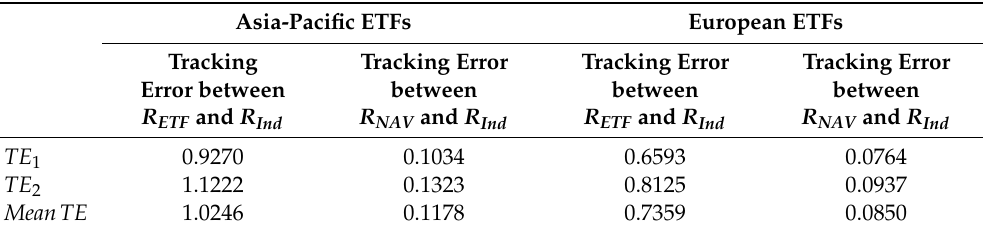
Table 4. Tracking errors of International